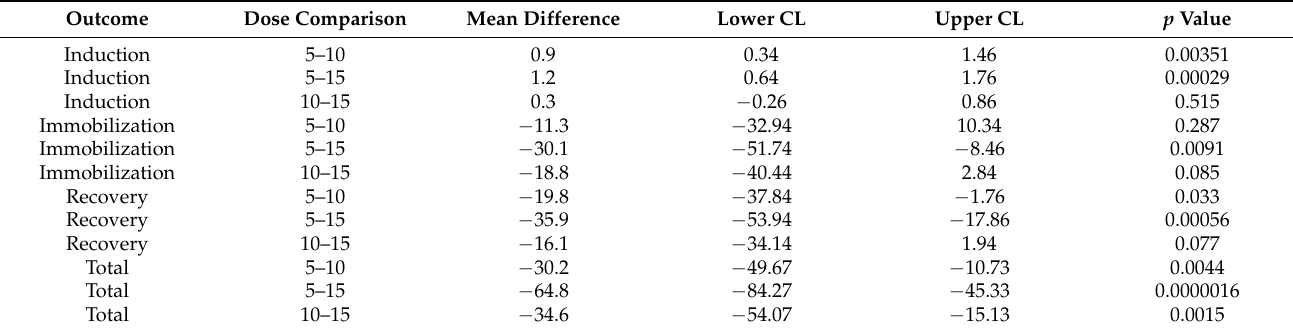
Table 2. Statistical summary.